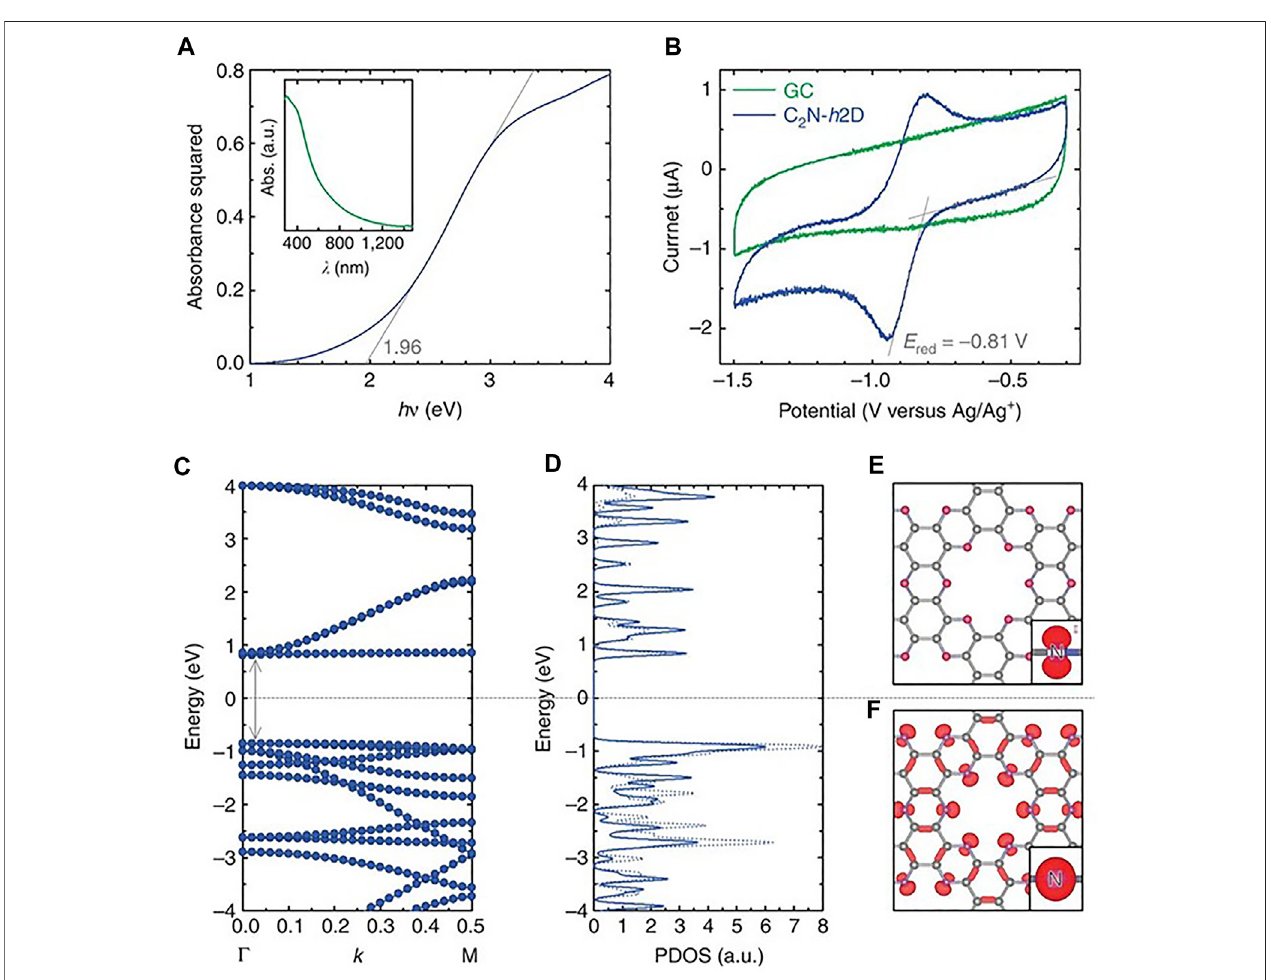
FIGURE 4 | Experimental and theoretical band gap calculations. Reproduced with permission from Mahmood et al. (2015).